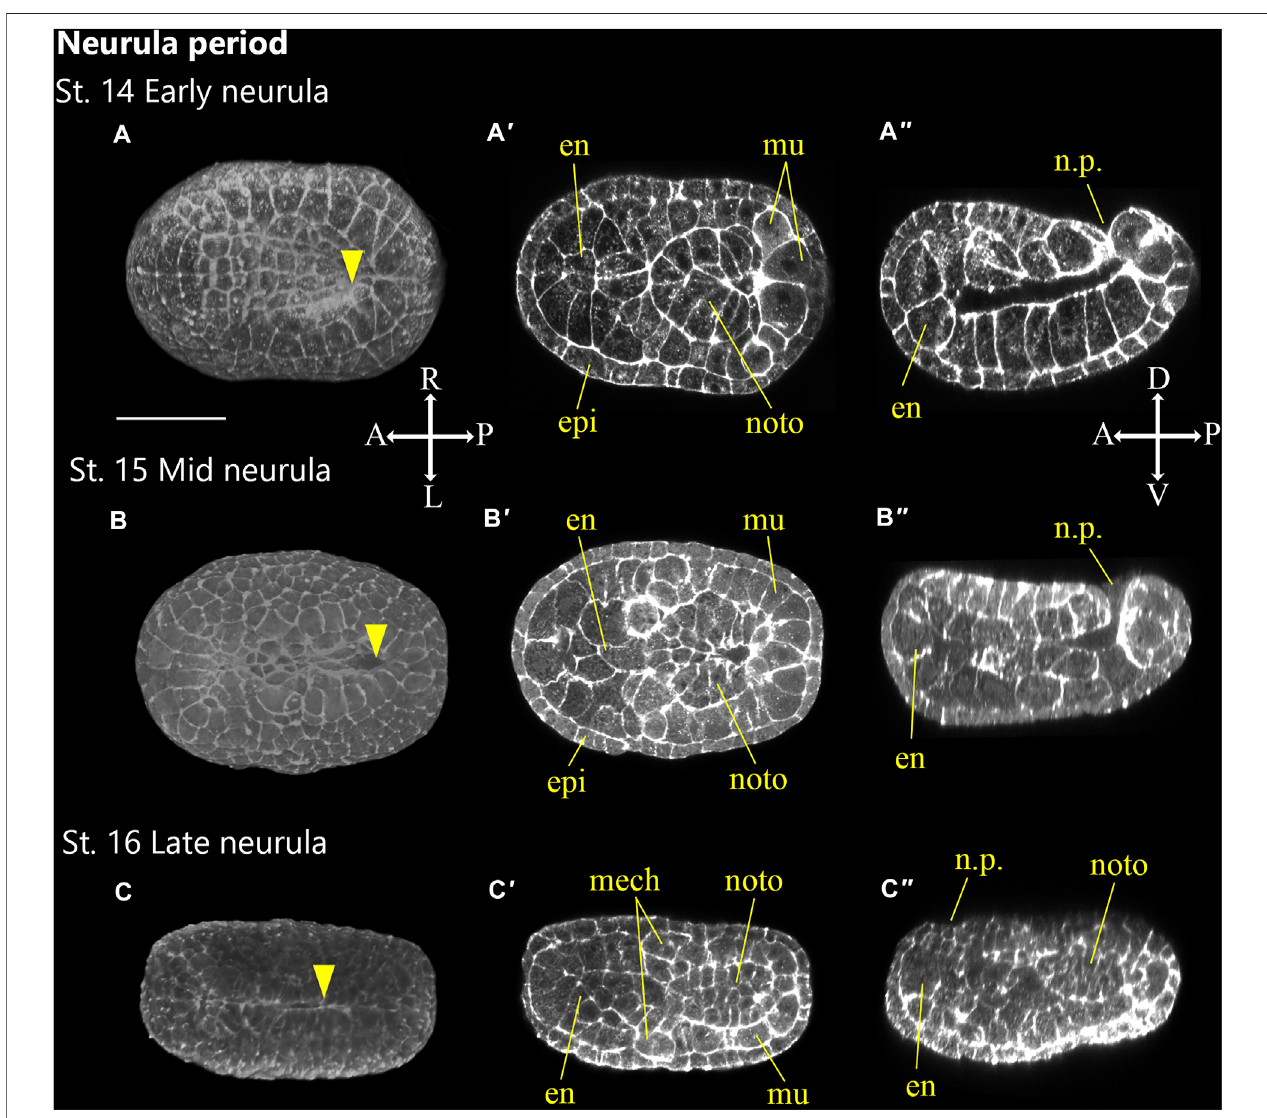
FIGURE 5 | Ascidiella aspersa embryos at neurula period. Embryos are stained with Alexa Fluor ™ 546 Phalloidin. Three-dimensional reconstructed images at (A) Stage14(earlyneurula), (B) Stage15(midneurula),and (C) Stage16(lateneurula).Three-dimensionalreconstructedimagesat (A) Stage14(earlyneurula), (B) Stage15 (mid neurula), and (C) Stage 16 (late neurula). (A – C) show the dorsal views of the embryos. (A 9 – C 9 ) show the cross-section, and (A 99 – C 99 ) show longitudinal section of (A – C) , respectively.Embryodirectionisshown byA,anterior;P,posterior;D, dorsal, and V,ventral. Arrowheadsindicates theanterior edgeofneural tube closure. en, endoderm; epi, epidermis; mech, mesenchyme; mu, muscle; noto, notochord; n.p., neuropore. Scale bar: 50 μ m.